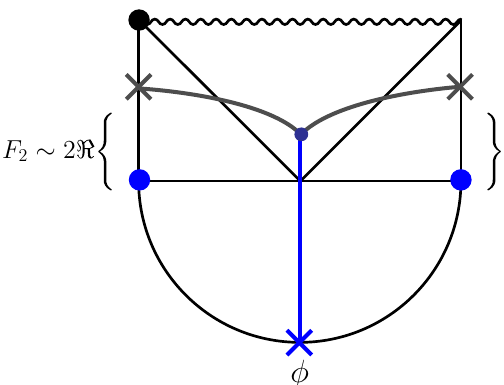
Figure 9. We show a schematic representation of the F 2 observable in the geodesic approximation for the BTZ scenario. The effect of the Euclidean leg in blue will ultimately deform the geodesics away from the diagram. Furthermore, in general, a geodesic interpretation of the correlator in this limit may not allow a “curve in complex spacetime” interpretation. The representation must then be taken more as a pedagogical drawing rather than a representation of the correlator as geodesics in